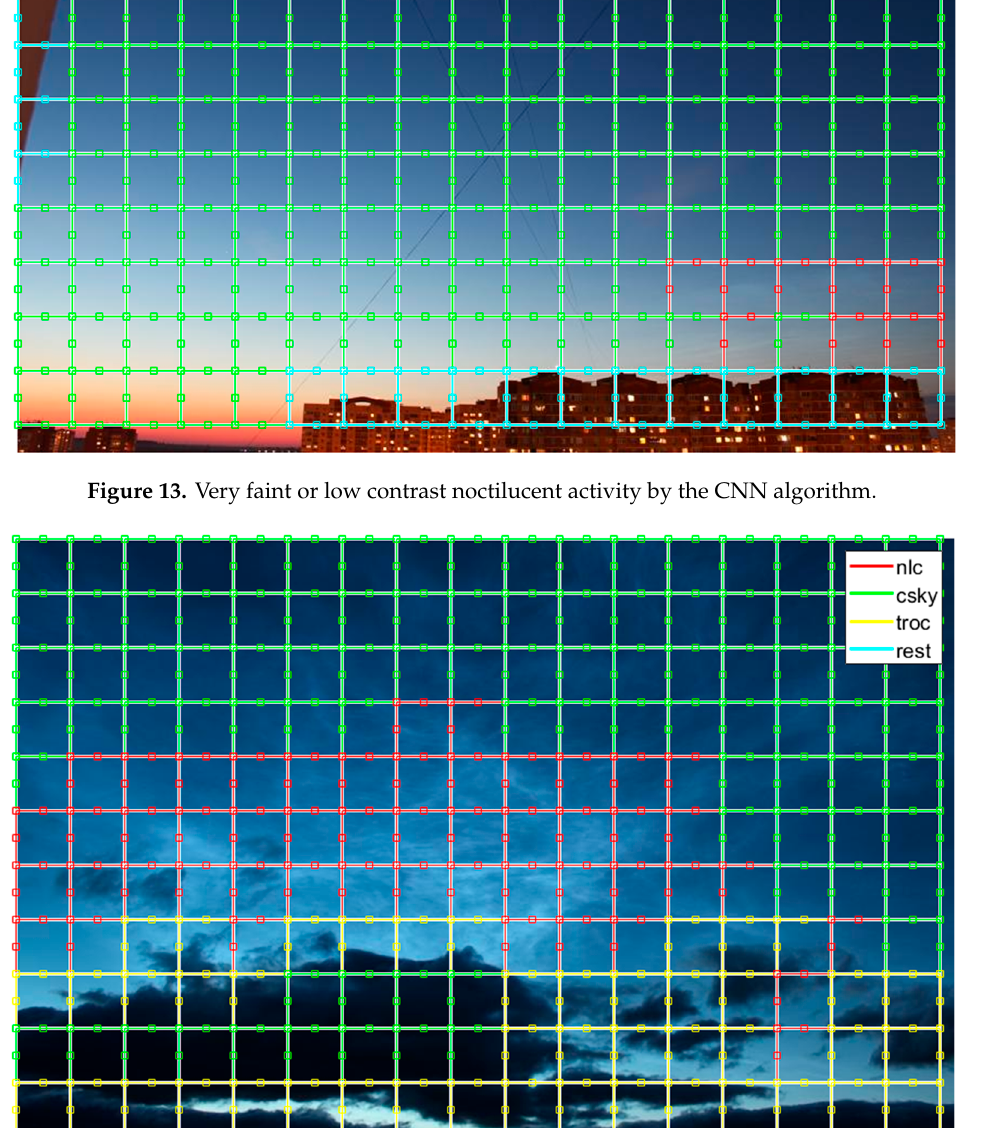
Figure 14. Noctilucent activity along with tropospheric clouds by the CNN algorithm.